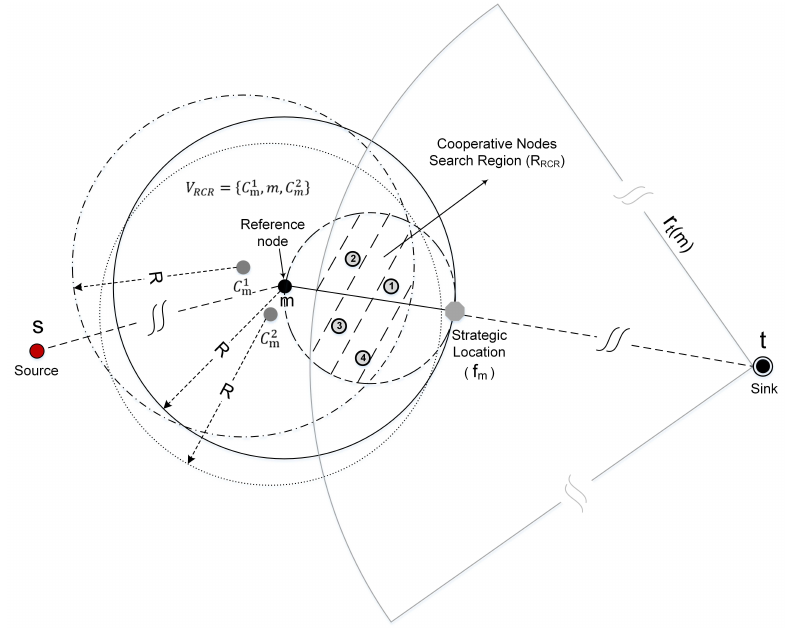
Figure 1. Illustration of the cooperative nodes search region.